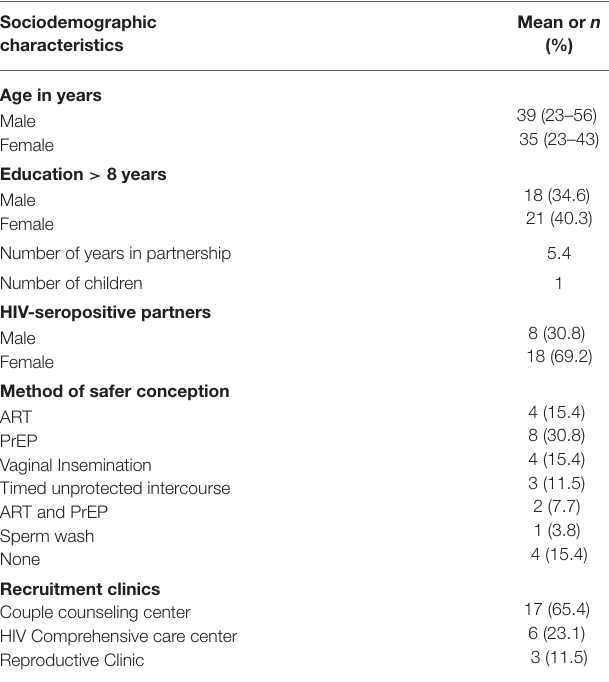
TABLE 1 | Baseline characteristics of the study sample ( N = 26 HIV-serodiscordant